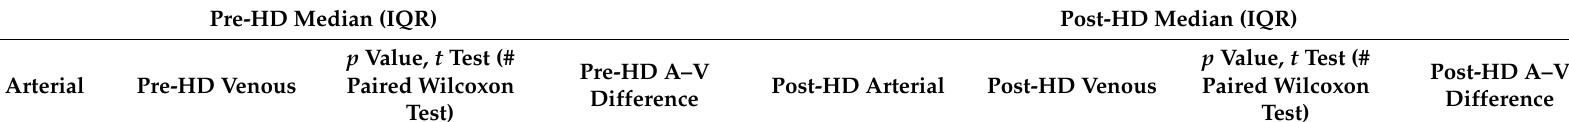
Table 3. Effects of hemodialysis on total fatty acids in plasma and RBCs in the CKD patients before (pre-HD) and at cessation (post-HD) of hemodialysis ( n = 12